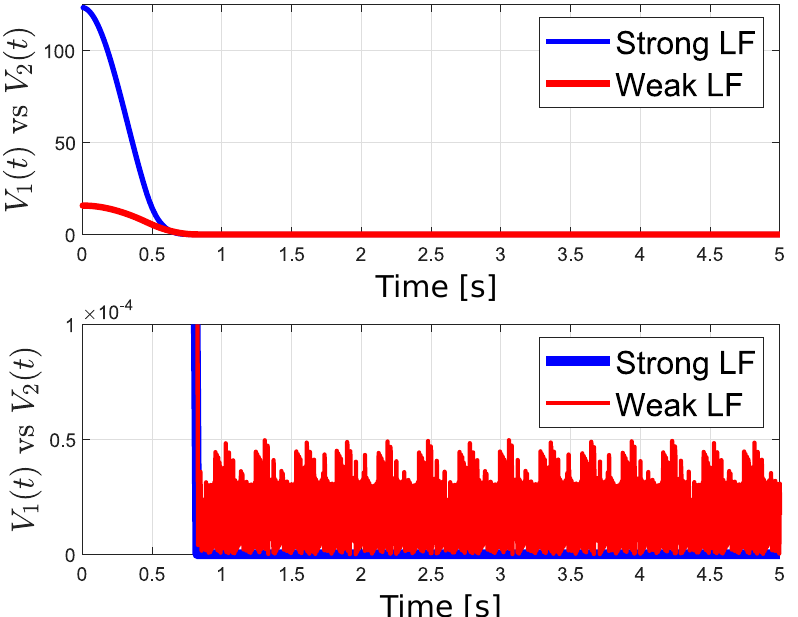
Figure 4. Lyapunov function dynamics. The continuous blue line corresponds to the proposed Lyapunov function, while the continuous red line represents the dynamics of Equation (4).